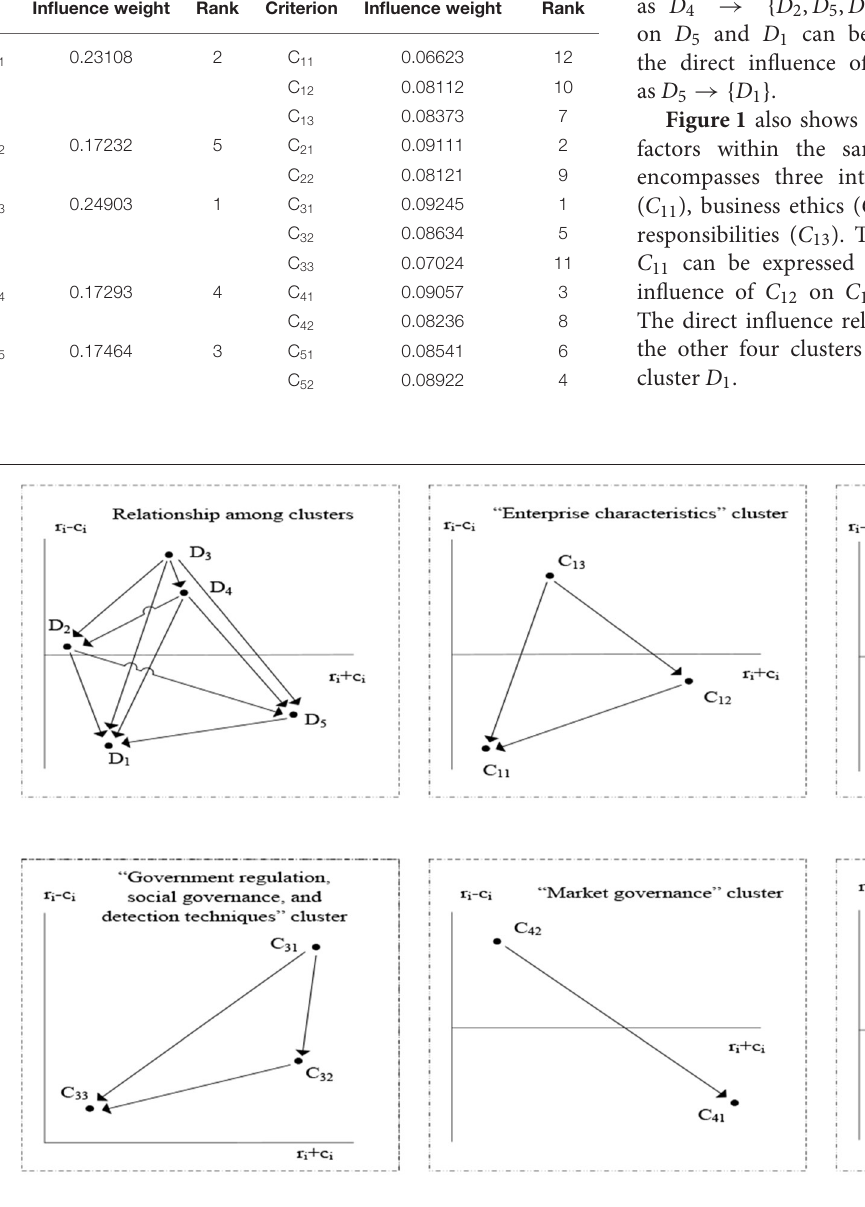
FIGURE 1 | Influence relationship net map among clusters and factors.